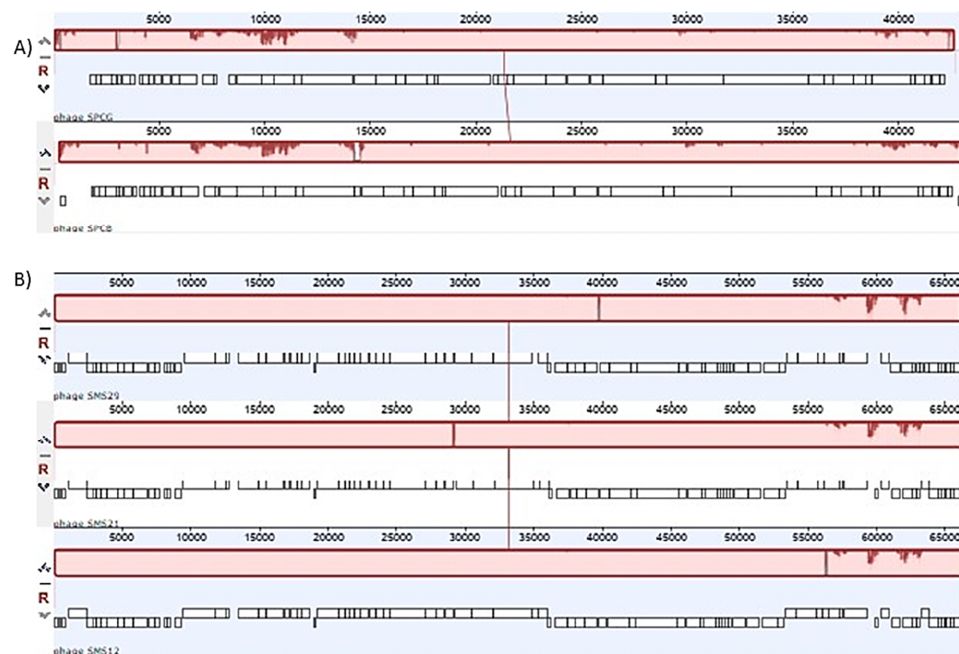
Figure 4. Comparison of phages from the two families: ( A ) Progressive MAUVE genome alignment between phages SPCB (above) and SPCG (below); ( B ) Progressive MAUVE genome alignment between phages SMS12, SMS21, and SMS29. White gap areas show regions that were not aligned and contain sequence elements specific to a particular genome. The height of the similarity profile presents an average level of conservation in a particular region of the genome sequence.